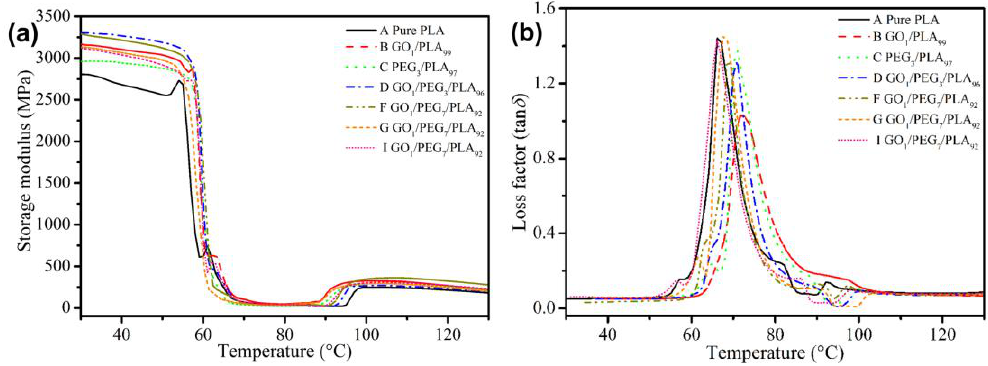
Figure 9. DMA curves of pure PLA, GO/PLA, PEG/PLA, and GO/PEG/PLA multi-phase composites in the case of different component ratio. ( a ) Storage modulus curves; ( b ) loss factor curves.